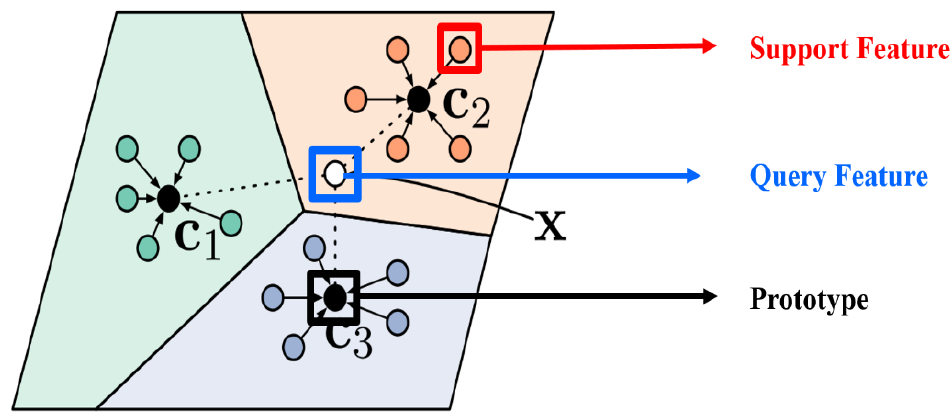
Figure 3. Prototypical network.